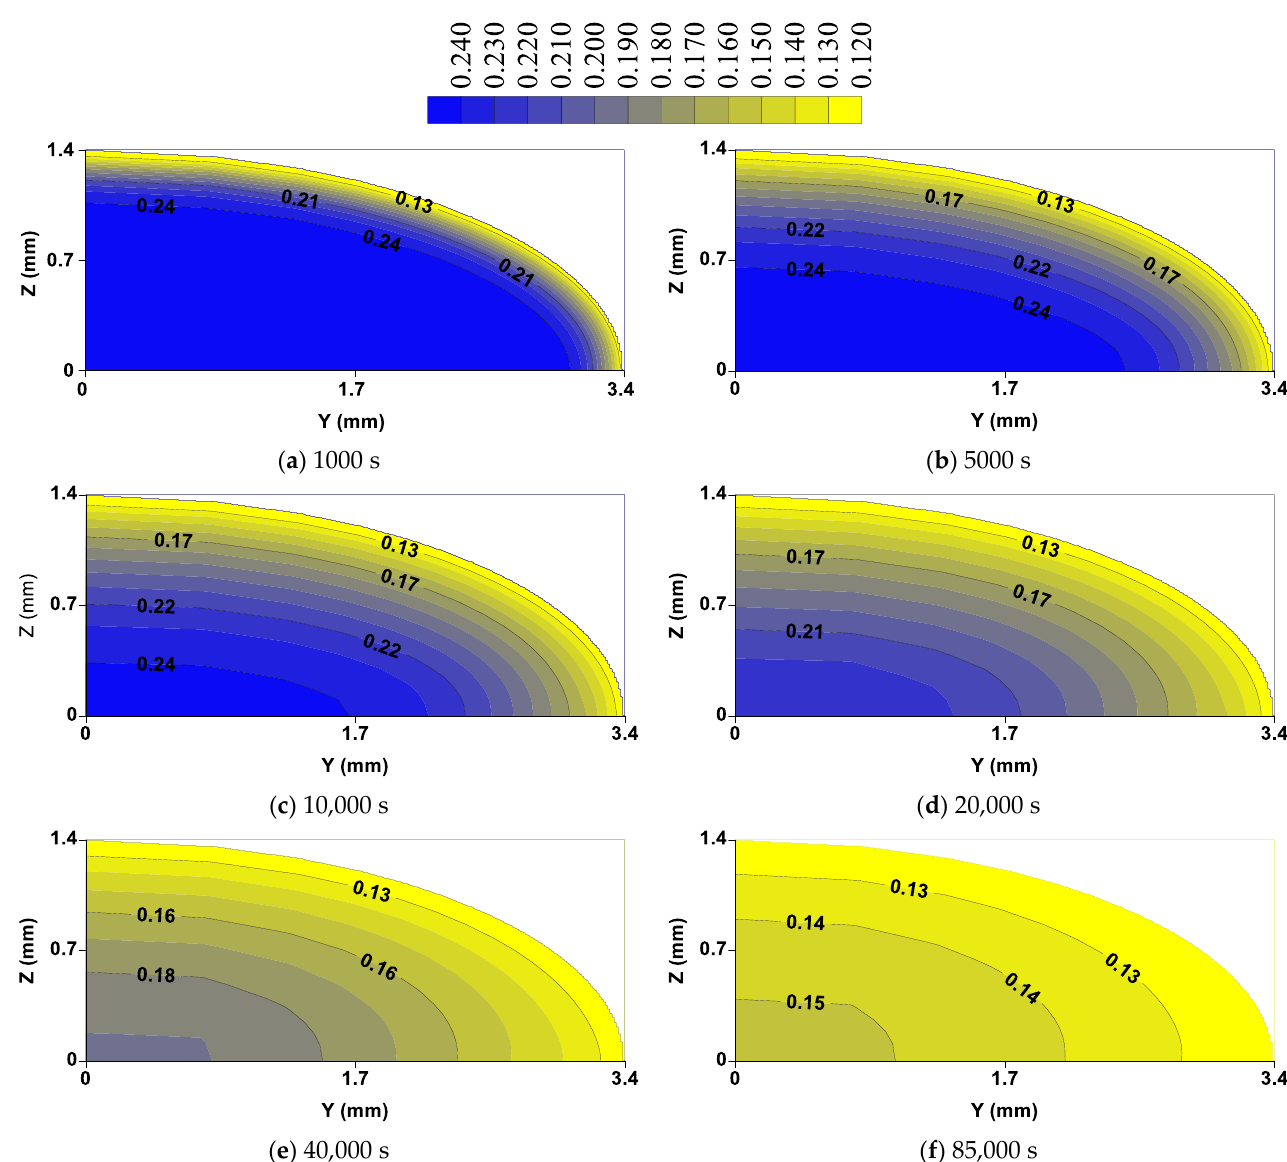
Figure 8. Distribution of moisture content inside lentil grain at different process moments, for drying at 40 °C and a relative humidity of 50%.